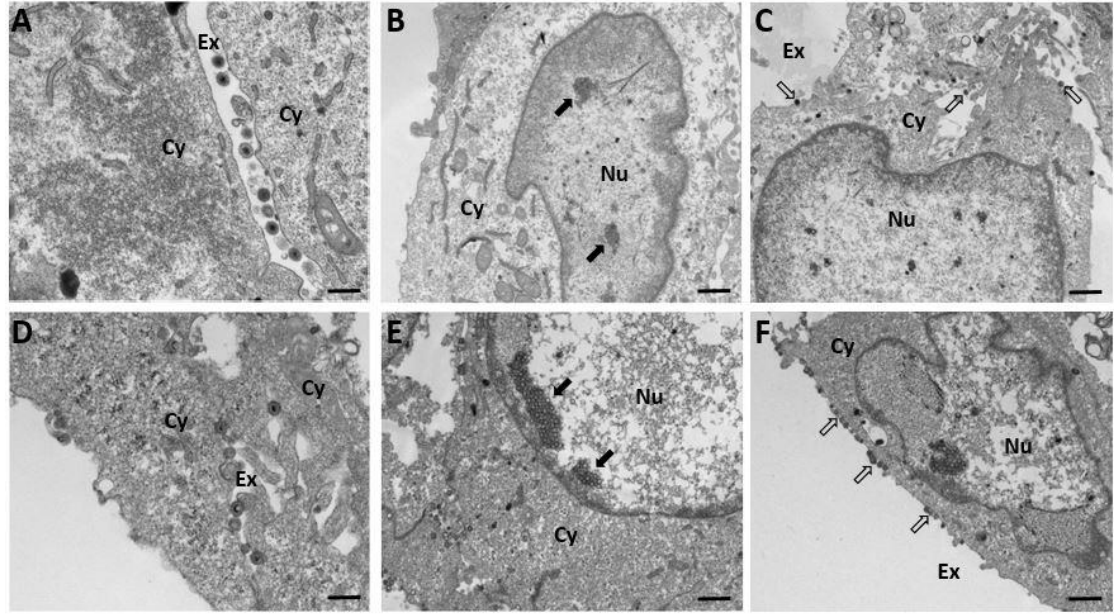
Figure 7. Transmission electron microscopy on PRV assembly in PK-15 cells. PK-15 cells were infected with PRV (Becker) at an MOI of 5 in the presence of U18666A (5 µ g/mL) or DMSO (0.1%, v / v ) control. Samples were harvested at 12 h post-infection and examined under transmission electron microscopy as described in Materials and Methods. The images obtained at higher magnification ( A , D ) show that mature PRV particles of similar size and morphology are produced from the DMSO-treated control ( A ) and the U18666A-treated group ( D ). For the images obtained at lower magnification ( B , C , E , F ), the black arrows indicate a cluster of PRV capsids in the nucleus of the DMSO-treated control ( B ) and the U18666A-treated group ( E ) while the white arrows indicate PRV particles in the extracellular space or on the plasma membrane of the DMSO-treated control ( C ) and the U18666A-treated group ( F ). Nu, nucleus; Cy, cytoplasm; Ex, extracellular space. Scale bar in ( A ) and ( D ), 400 nm. Scale bar in ( B ), ( C ), ( E ) , and F, 1 μm.